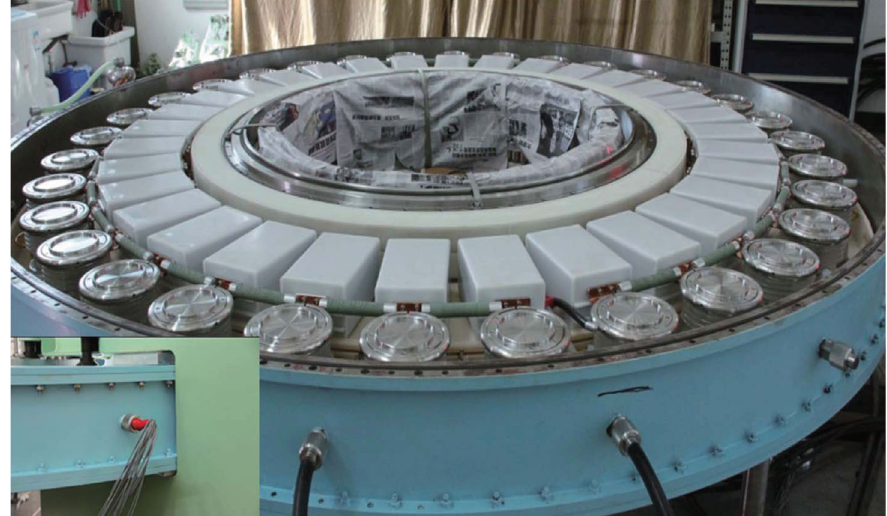
FIG. 15. Photo of the LTD cavity which is under testing. The subfigure shows the entrance into the cavity for fibers, which were used to monitor the light emission from switches.